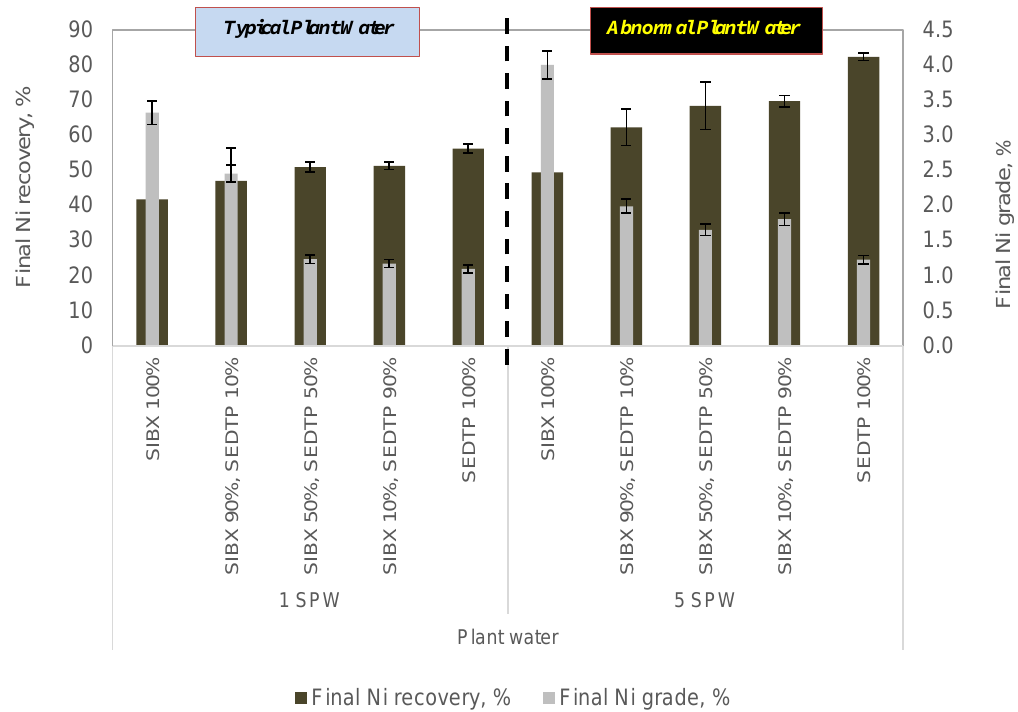
Figure 4. Final nickel recoveries and grades for all SIBX / SEDTP mixtures and ionic strengths of process water.